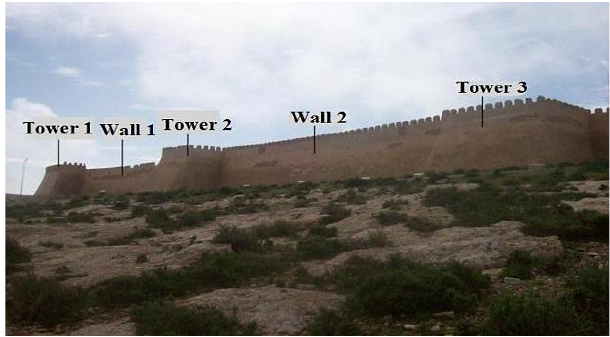
Figure 4. The height of the wall equal to the kasbahtowers.